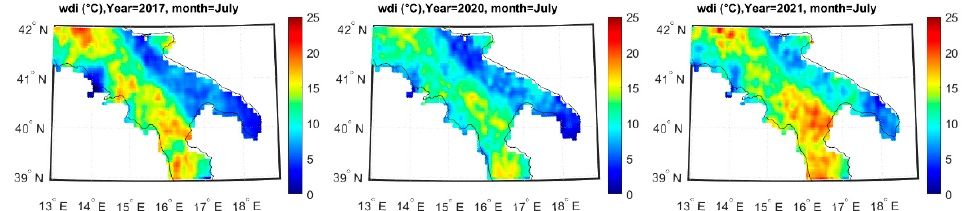
Figure 7. Exemplifying the 𝑤𝑑𝑖 evolution through the years. From left to right: July 2017, 2020, and 2021.